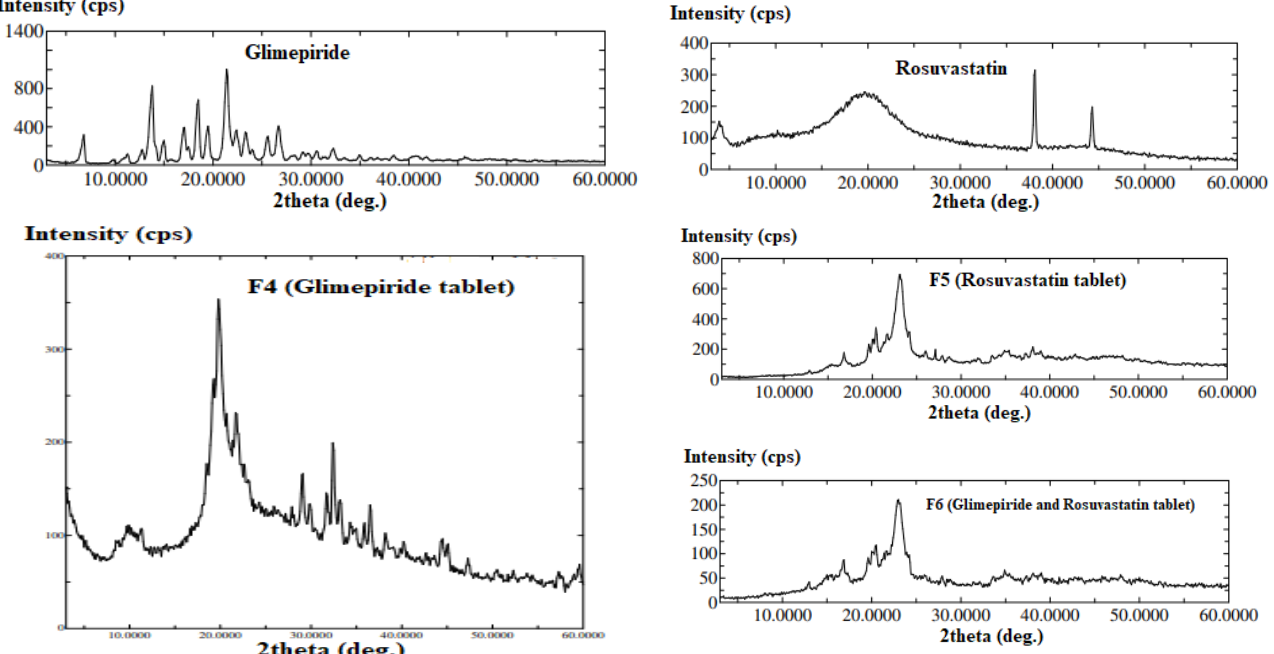
Figure 5. X-ray diffraction patterns of glimepiride, rosuvastatin, and the prepared 3DP tablets.